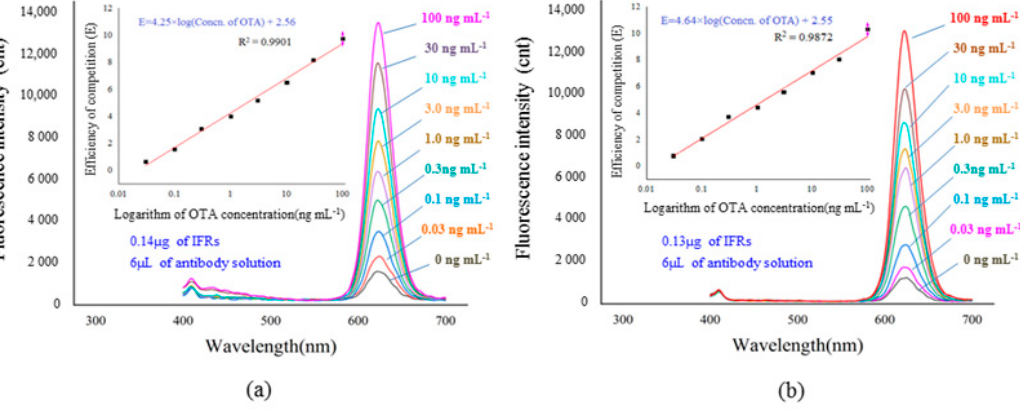
Figure 5. The standard curves of immuno-separated assays by different conditions. ( a ) The system based on 0.14 µ g of reporters and 6 µ L of antibody solution. ( b ) The system based on 0.13 µ g of reporters and 6 µ L of antibody solution.